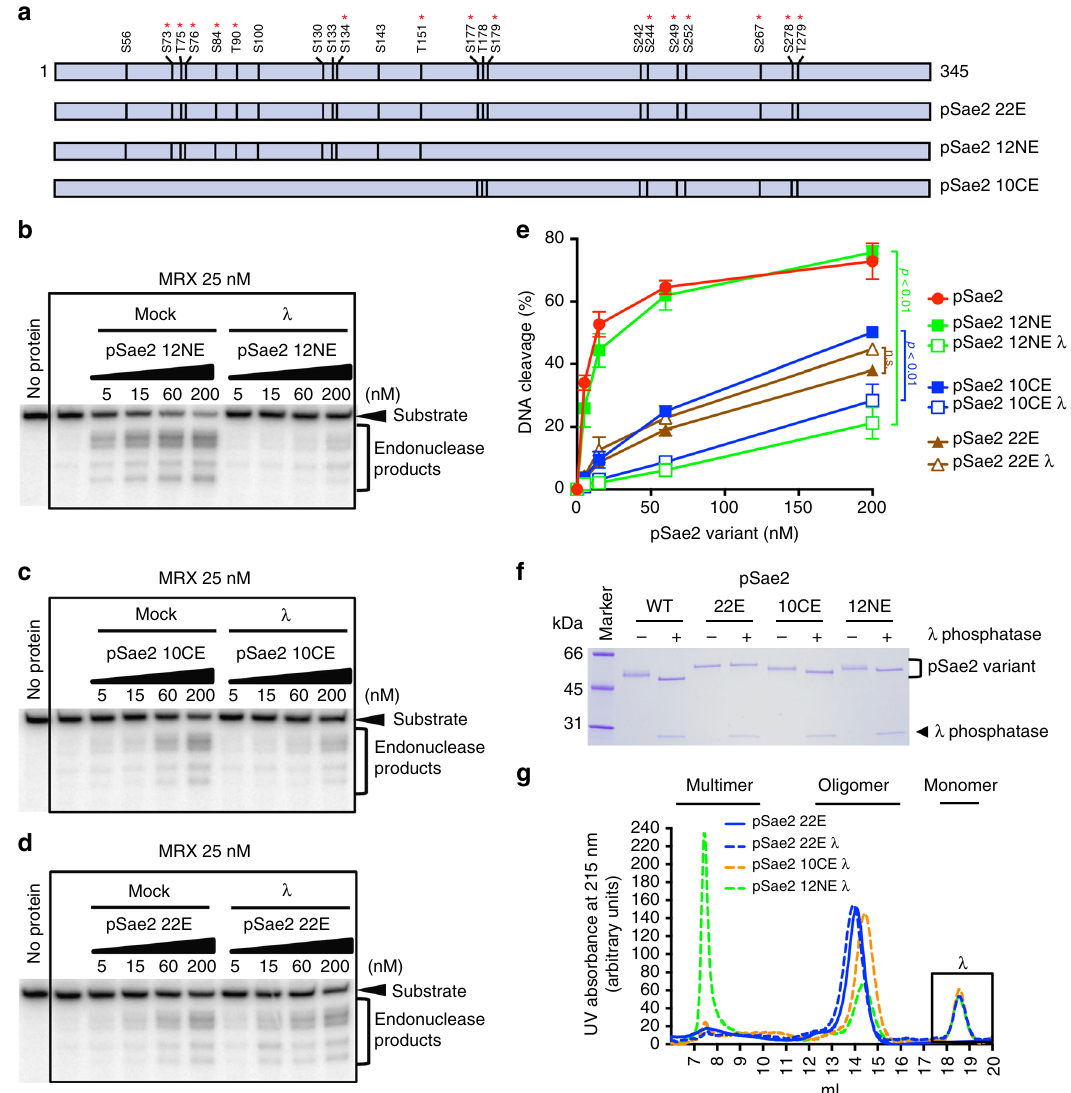
Fig. 5 Multiple residues in Sae2 must be phosphorylated to prevent multimerization and promote MRX. a Overview of putative phosphorylation sites in pSae2 based on our mass spectrometric analysis and previous reports 8,12,41 . The red asterisk indicates pSae2 residues found phosphorylated in vivo in previous studies. The pSae2 22E mutant contains 22 phosphomimicking substitutions. The pSae2 12NE mutant contains 12 phosphomimicking substitutions in the N-terminal part of the protein. The pSae2 10CE mutant contains 10 phosphomimicking substitutions in the C-terminal part of the protein. All mutants were prepared in the presence of phosphatase inhibitors. b – g Analysis of the pSae2 22E, pSae2 12NE, and pSae2 10CE mutants. The polypeptides were mock-treated or dephosphorylated with λ phosphatase and subjected to nuclease assays with MRX ( b – d ). Substrate used was the same as in Fig. 1c. e shows quantitation of the experiments such as shown in b – d , error bars, SEM; n = 3. f shows a representative polyacrylamide gel (4 – 15% gradient) electrophoretic analysis of the respective mutants treated or not with λ phosphatase. g shows a representative size exclusion chromatography pro fi le of the indicated mutants mock-treated or dephosphorylated with λ phosphatase. The rectangle indicates the position of λ